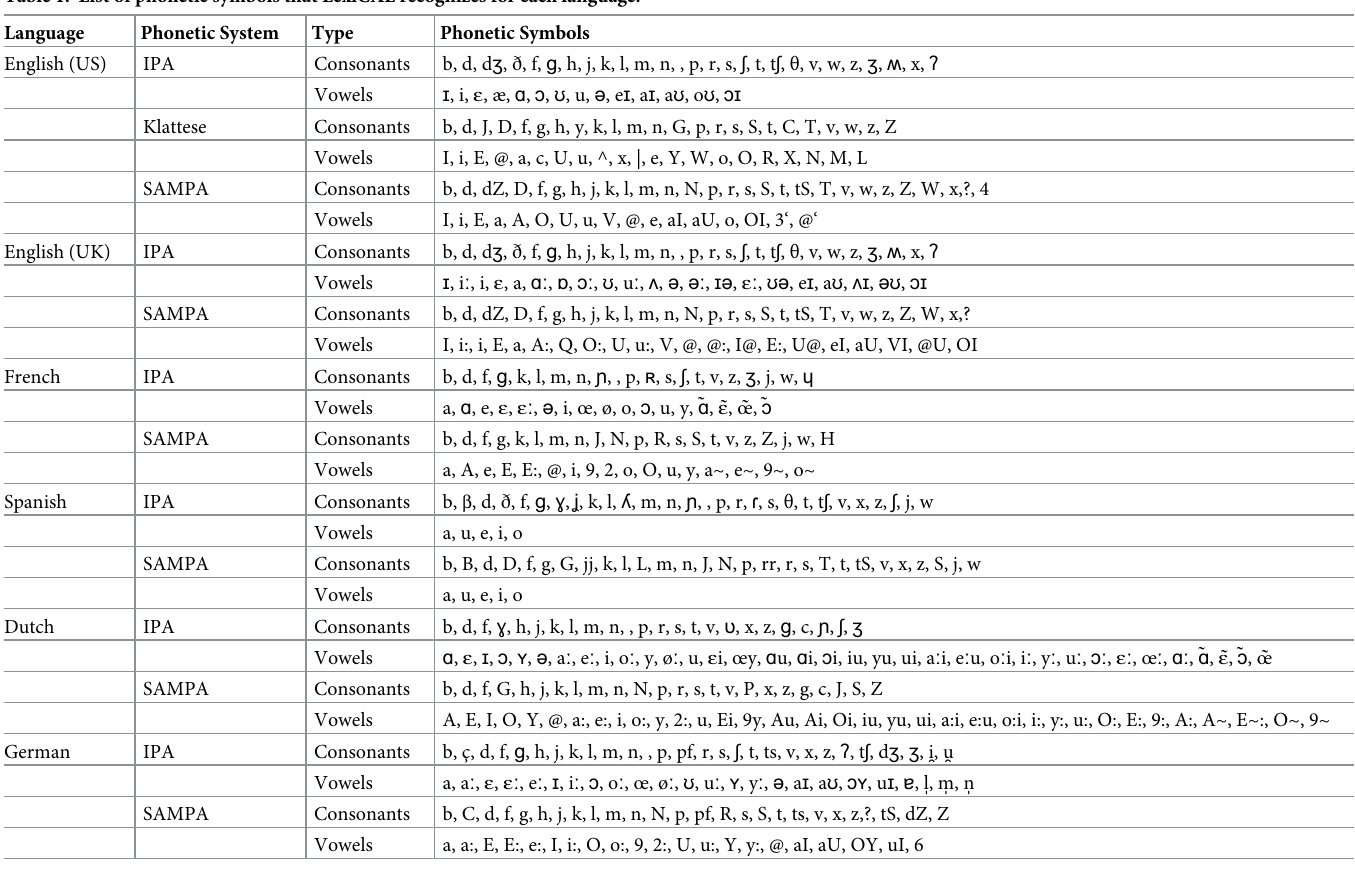
Table 1. List of phonetic symbols that LexiCAL recognizes for each